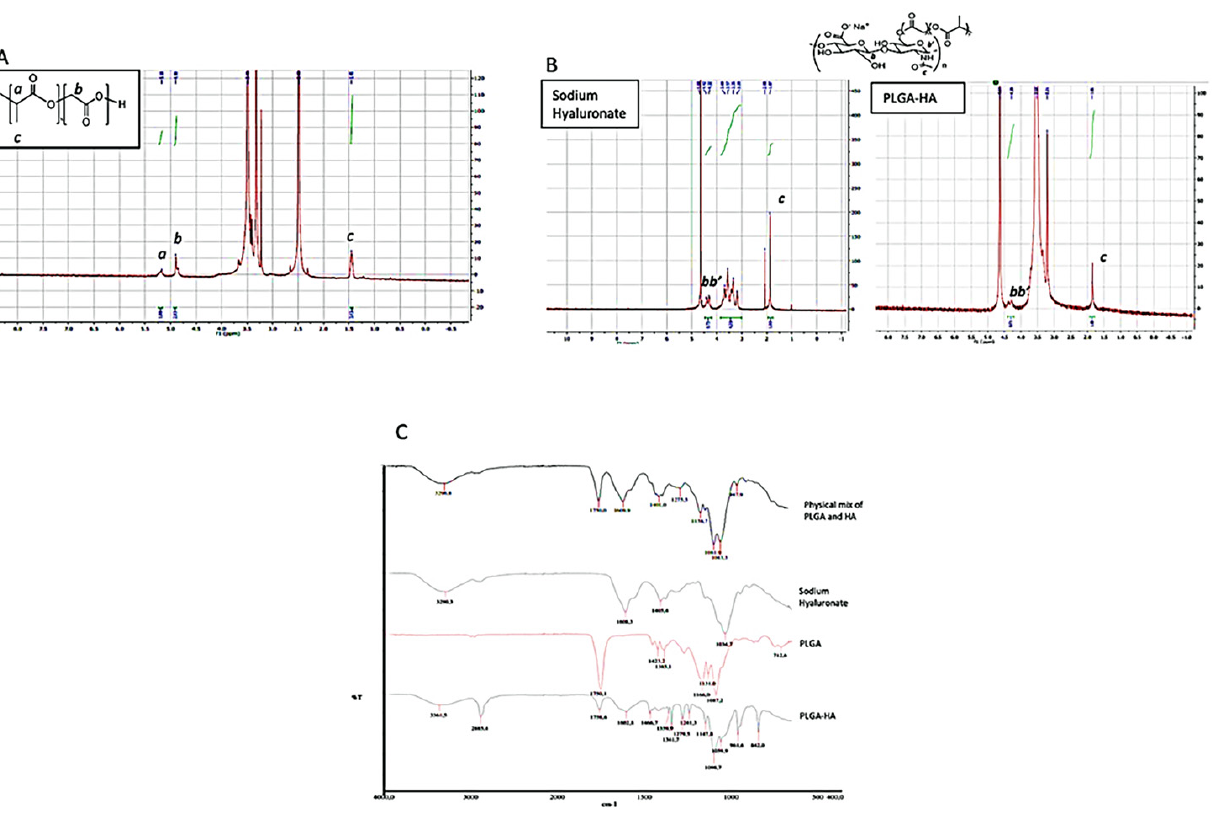
Figure 2. Characterization of the synthesized PLGA-HA polymer. ( A ) 1H-NMR spectrum in DMSO of PLGA-HA ( B ) From left to right side, respectively, 1 H-NMR spectra in D 2 O of sodium hyaluronate and PLGA-HA ( C ) From top to bottom, IR spectrums of the physical mix of PLGA and HA, HA, PLGA, and